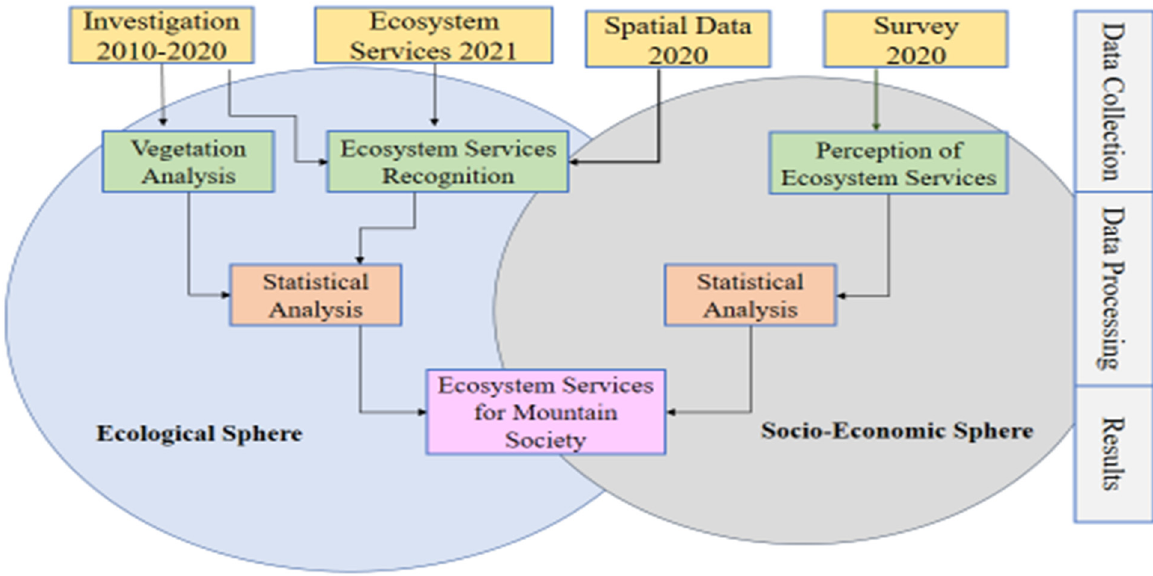
Figure 1. Methodology scheme used in assessment of Monotheca phytocoenoses forests ecosystem services.